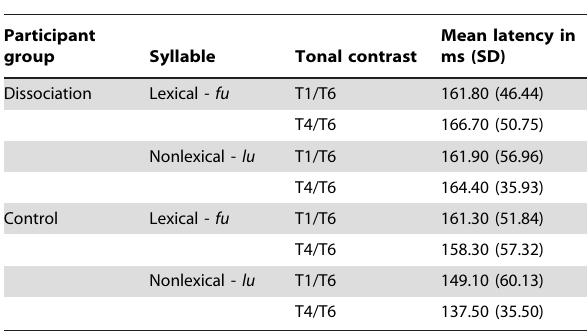
Table 2. MMN peak latencies (post-divergence point) by participant group in different syllable and tonal contrast conditions.